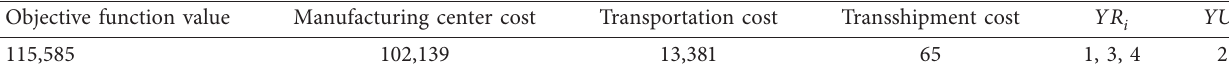
Table 2: Results of the study.